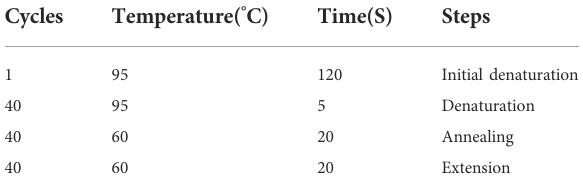
TABLE 2 PCR cycling condition.